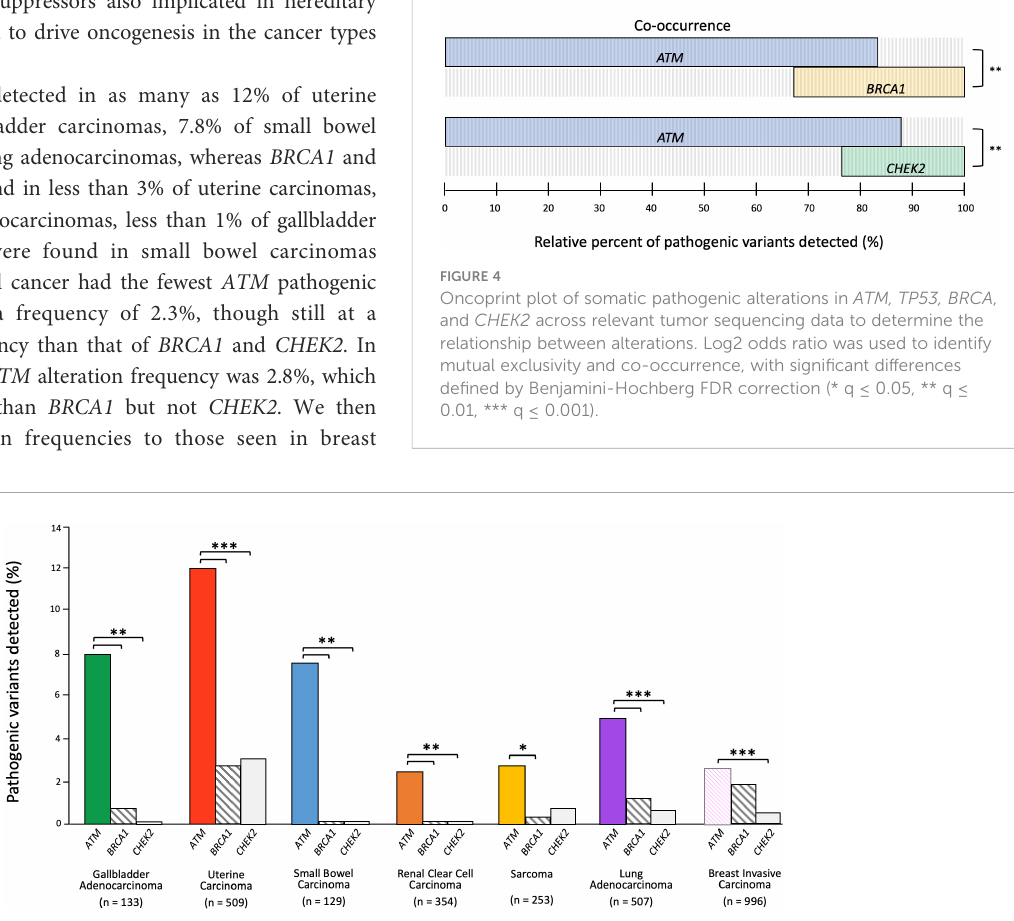
FIGURE 3 ATM somatic alteration frequency compared to BRCA1 and CHEK2 alterations in relevant cancers. Z-test for independent proportions was used to identify signi fi cant differences (* p ≤ 0.05, ** p ≤ 0.01, *** p ≤ 0.001, all other comparisons not signi fi cant). Tumor sequencing data was accessed through cBioPortal.